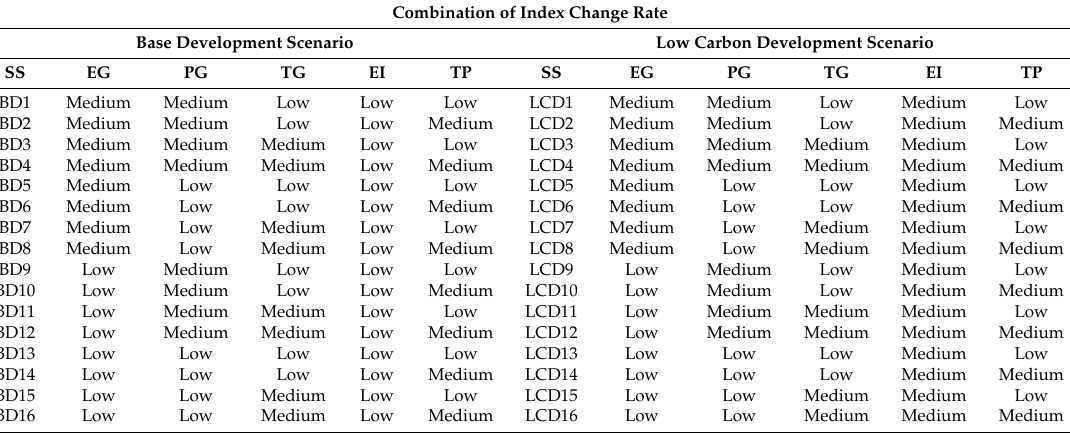
Table 9. Parameters setting of different development